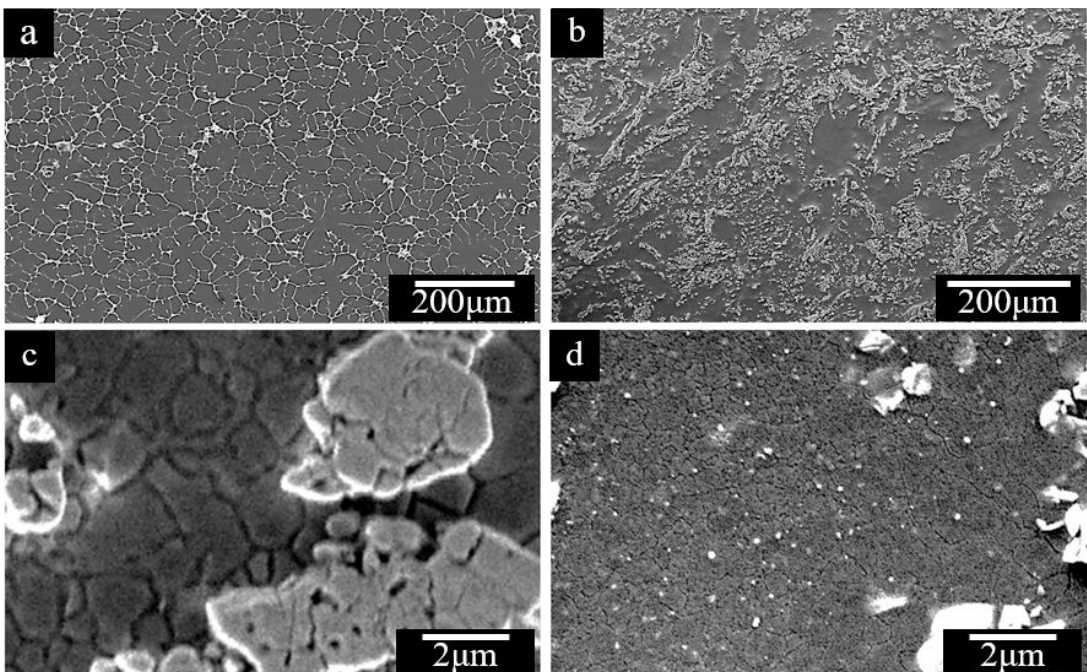
Figure 4. SEM images of ZK60+2.5Mm alloy after ( a ) as-cast and ( b ) ECAP+LTR in the BSE mode; ( c ) ECAP+CR and ( d ) ECAP+LTR in the SE